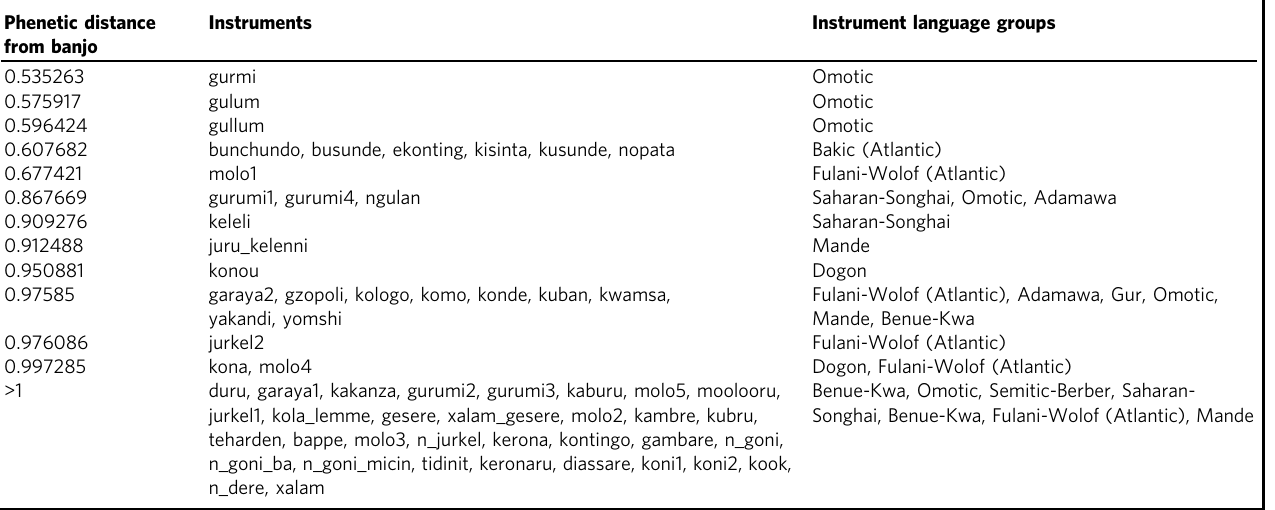
Table 2 Minimum edge-wise phenetic distances separating instruments from the banjo on the NeightborNet network. Phenetic distance from banjo